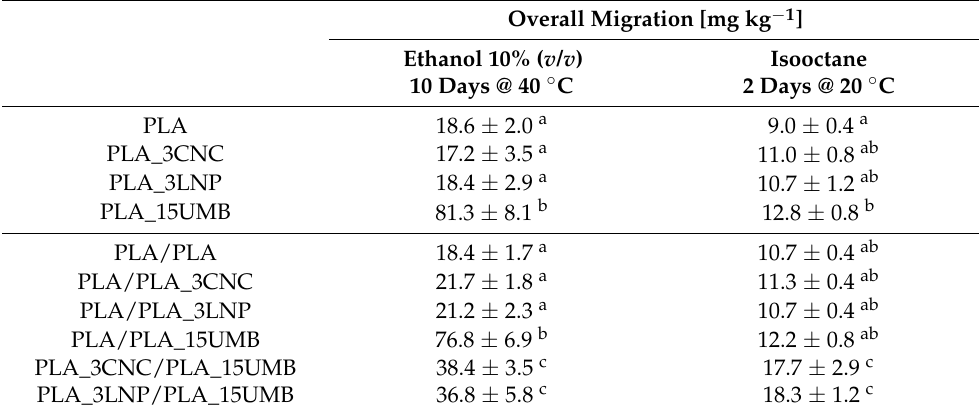
Table 4. Overall migration characterization data of PLA (neat and nanocomposites) monolayer and bilayer